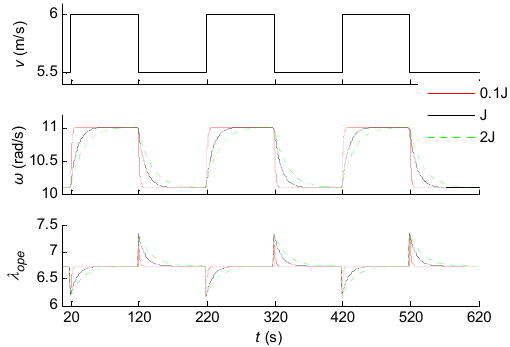
Figure 2. Response of wind turbines with different rotor inertia excited by a same step wind speed.